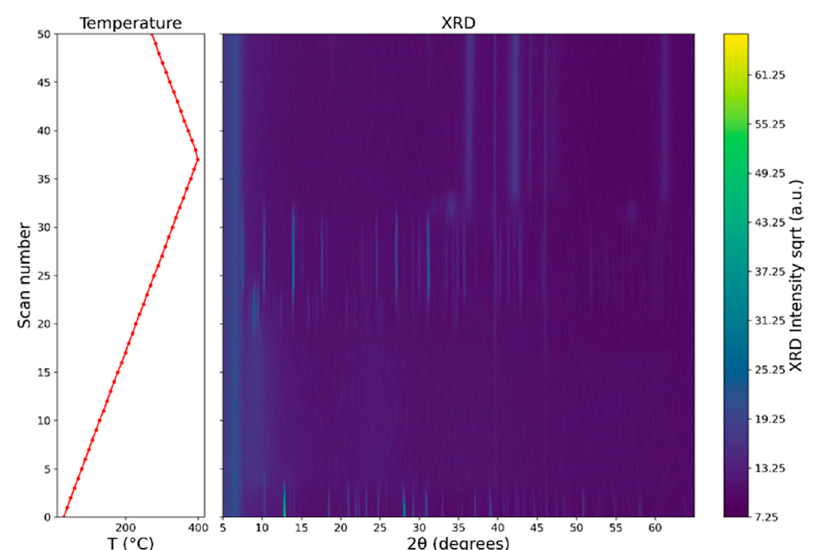
Figure 3. X-ray powder diffraction thermal evolution for cobalt (II) acetate tetrahydrate under N 2 between RT and 400 °C (heating) and then cooled down to 270 °C. Intensity scale as square root. Note the presence of a width scattering bump around 2 θ = 7 ° coming out from the camera, as well as main platinum peaks around 41.0° and 47.7 °. 2 θ values (ICDD PDF card 01-087-0642) produced by the camera heating element are present in some scans .